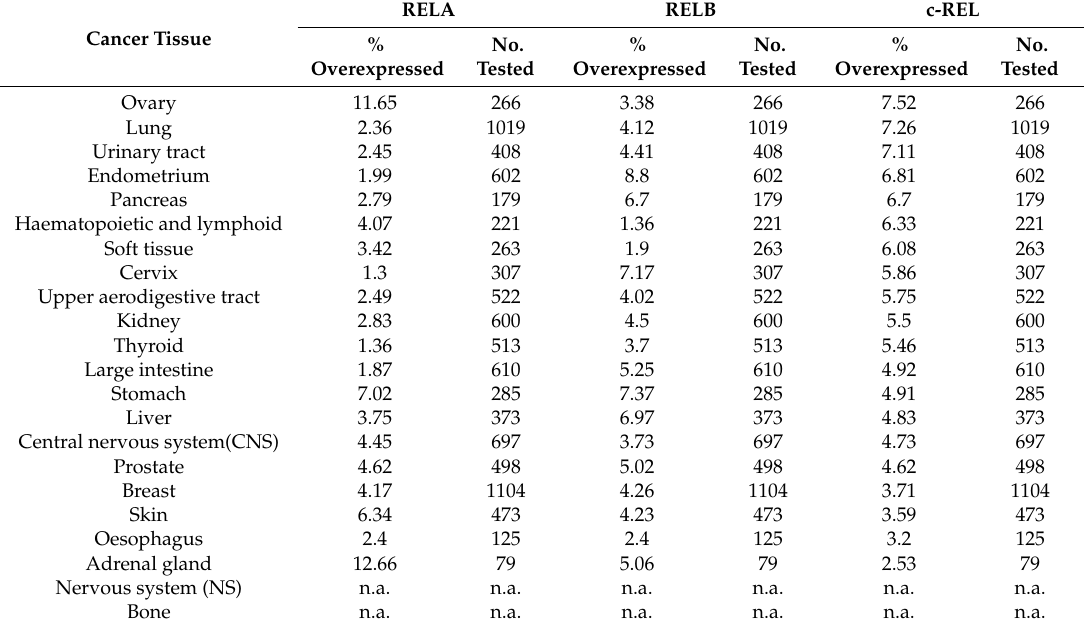
Table 1. Overexpression of NF- κ B subunits in distinct human cancer tissues. COSMIC was used